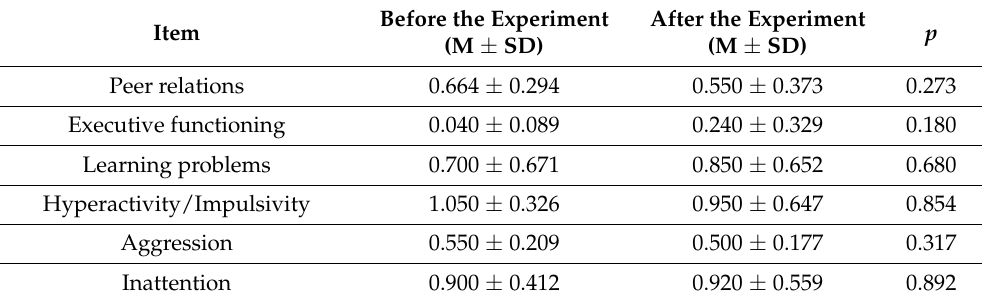
Table 5. The Conners Child Behavior Scores in the control group before and after the experiment. Before the Experiment After the Experiment Item (M ± SD) Peer relations